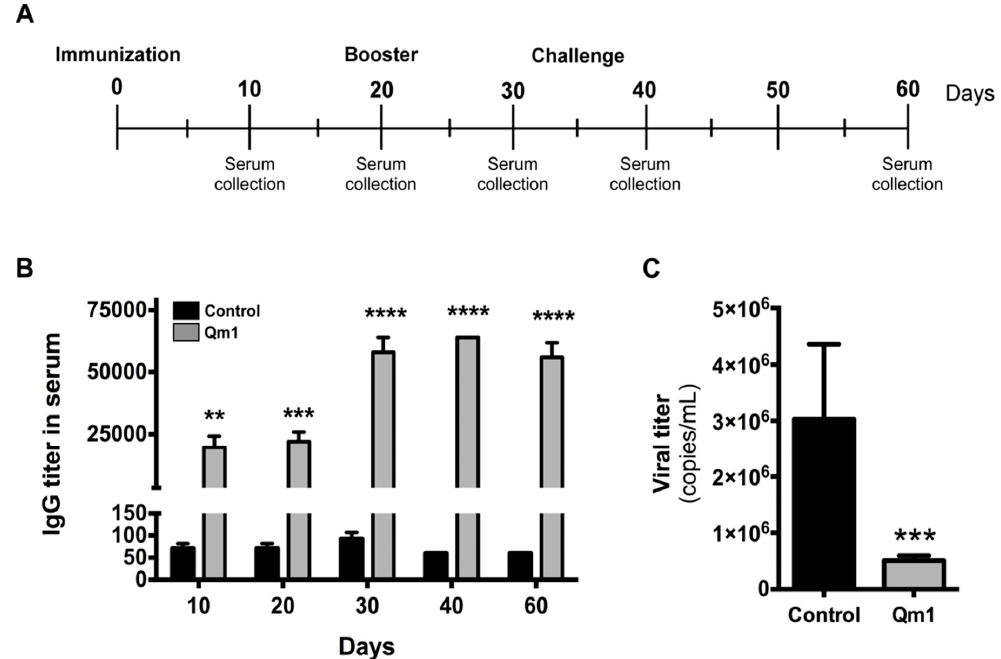
Figure 9. Analysis of the antibody and antiviral response to PCV2 in pigs. ( A ) The immunization and viral challenge schedule. ( B ) IgG titer in serum measured in pigs vaccinated with Qm1 (grey) or the vehicle PBS (black) by indirect ELISA at the indicated days. ( C ) The pig serum was collected at day 60 and the viral titer was quantified in challenged pigs by qRT-PCR using SensiMixTM SYBR Hi-ROX kit (Bioline). The values are the mean ± standard error mean (SEM). n = 6, two-way ANOVA and the Sidak test for IgG titer and the Student’s t -test for viral titer ** p < 0.01; *** p < 0.001; **** p < 0.0001 vs. the control group.